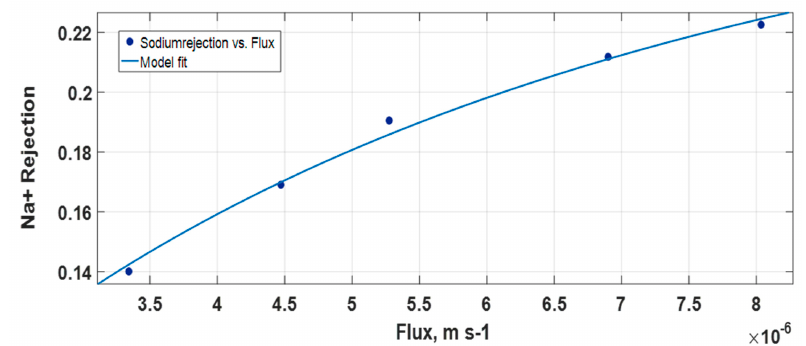
Figure 2. Rejection versus flux (m s -1 ) for Na + for NANO-SW.